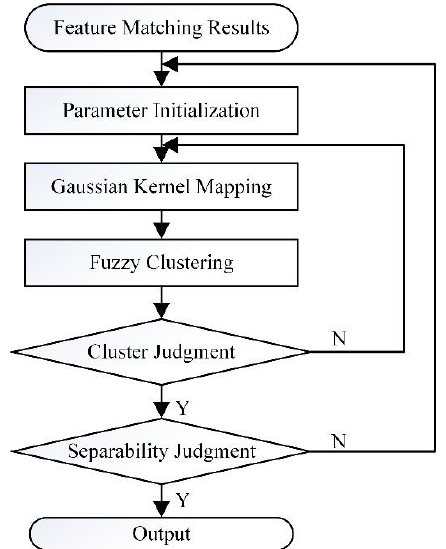
Figure 2. The Gaussian Kernel Fuzzy Clustering algorithm flowchart